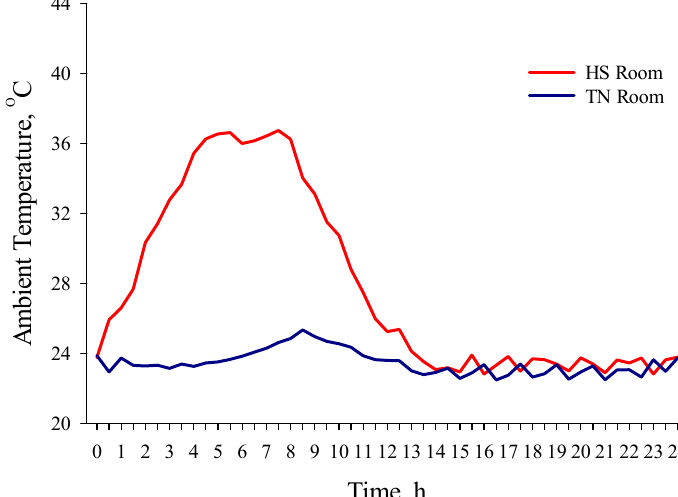
Figure 1. Ambient temperature by time during the 24 h of cyclic heat stress in thermoneutral (TN) and heat stress (HS) rooms.